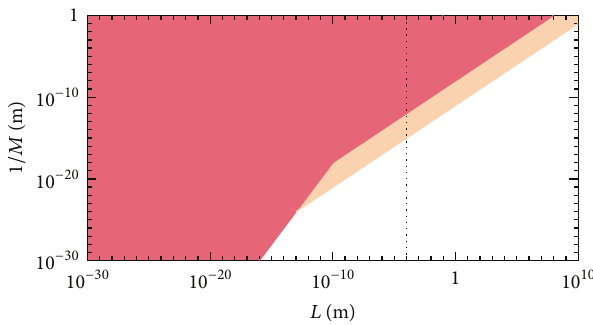
Figure 3: Summary of constraints on local space-time defects, from [5]. The red (dark) shaded region is excluded. The peachy (light) shaded region indicates a stronger constraint from photon decay with the ad hoc assumption that the typical distance between defects increases with the cosmological scale